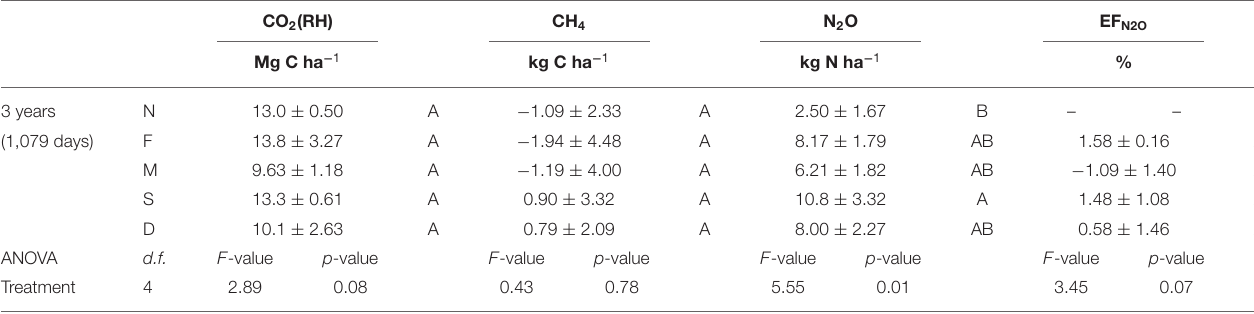
TABLE 4 | Cumulative CO 2 (RH), CH 4 , and N 2 O emissions and the N 2 O emission factor (EF N2O ) for 3-year total. CO 2